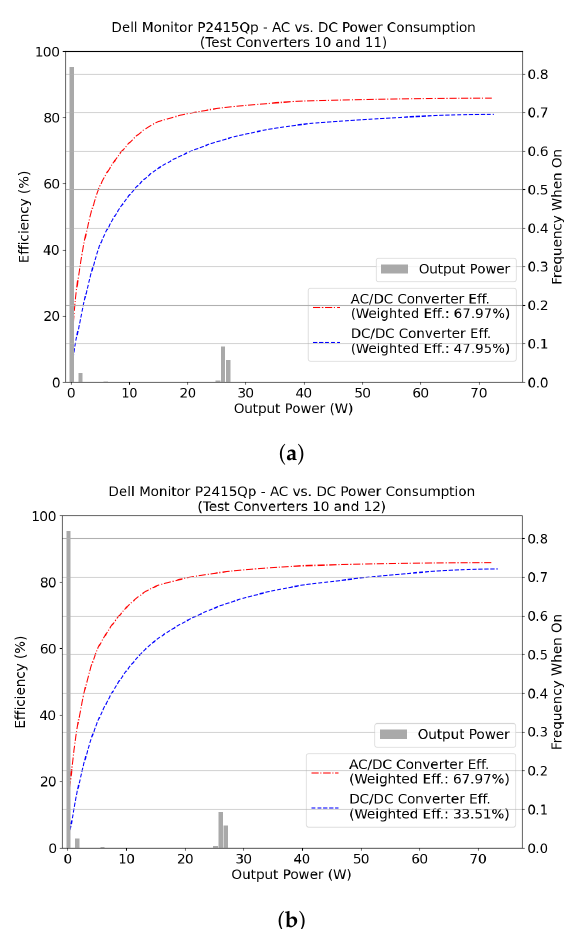
Figure 7. AC/DC and DC/DC weighted energy efficiencies for a load profile from a Dell monitor, model P2415Qp, rated at 90 W. Simulations utilized efficiency data from 110 W SIMO test converters. Both panels utilize the same AC/DC converter. Panel ( a ) compares to a DC/DC converter with 24 V DC input; panel ( b ) with 48 V DC input. Formatted as in Figure